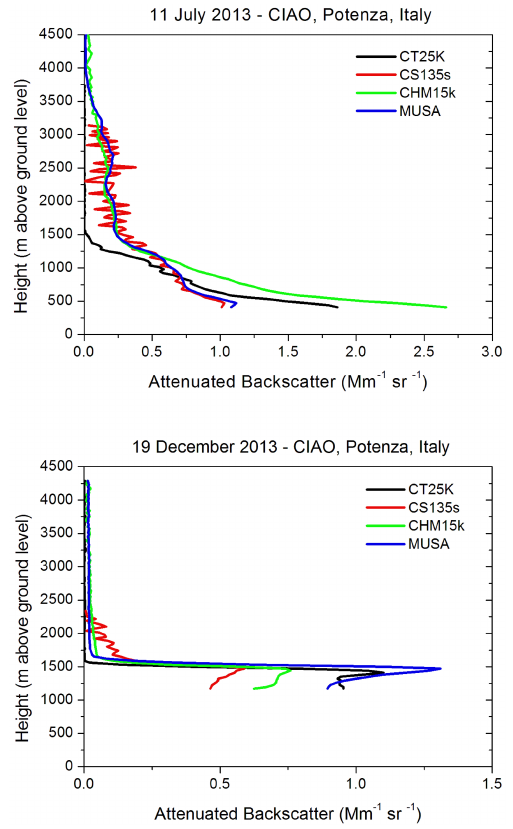
Figure 8. Comparison between the attenuated backscatter coeffi- cient profiles provided by the four instruments (MUSA, CHM15k, CT25K, CS135s) on 11 July 2013 in the time interval between 20:50 and 22:22UTC (upper panel), and on 19 December 2013 in the time interval between 16:49 and 18:10UTC (lower panel). CHM15k is not corrected for the overlap